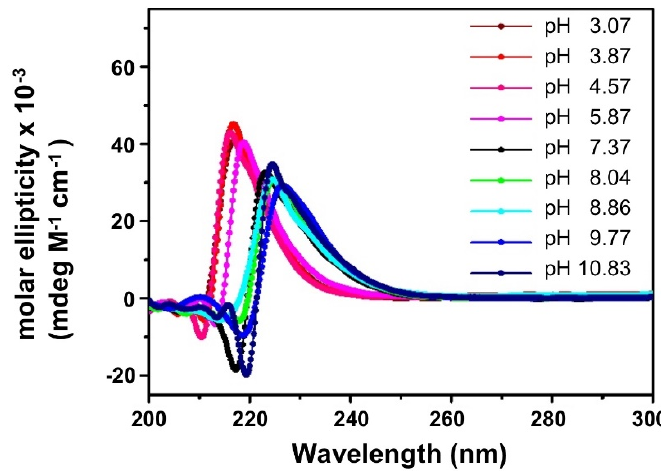
Figure 3. pH-Dependence of M- L -Gln CD spectra. Data obtained at 25 °C in 0.1 M NaCl with a repeat unit concentration of 1.66 mM.